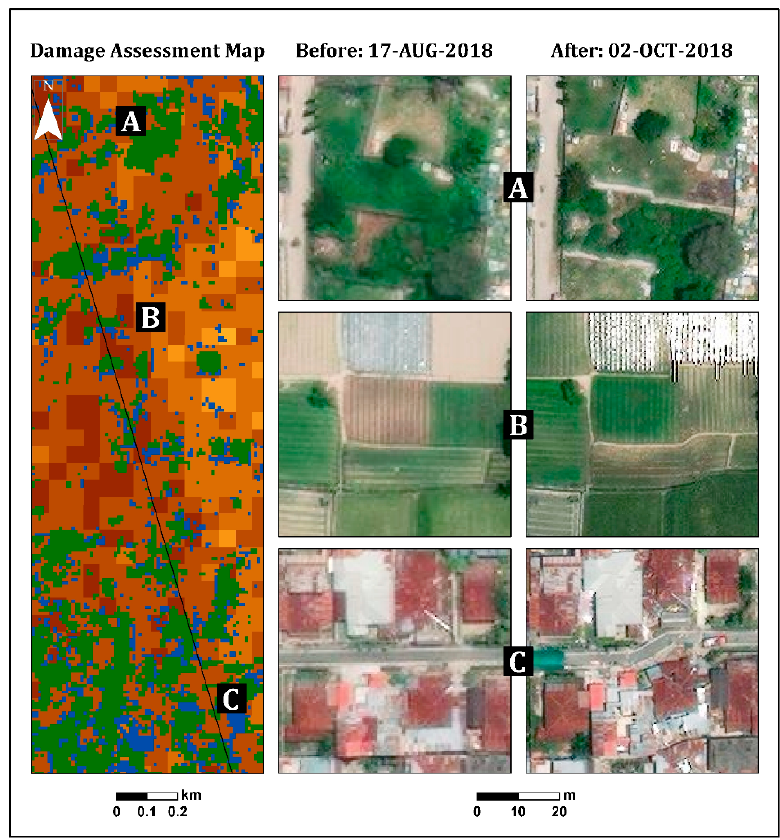
Figure 6. Illustration of the surface rupture caused by the 2018 Sulawesi Indonesia earthquake in ( A ) natural vegetation, ( B ) agricultural fields, and ( C ) a built-up area. In the urban area, the damage assessment map displayed less damage (light colors) in the inland region than in the coastal region, as expected (Figure 7). Refs. [38,39,42,43] displayed similar results, showing that most of the damage occurred along the Palu city coastline, where most of the buildings were washed away by the tsunami, and buildings inland were affected by the earthquake but not completely destroyed. Moreover, this map displayed the differences between the damage levels of the urban areas (coastline and inland regions) and the rural areas. As can be seen in Figure 7, the rural area displayed higher levels of damage (mostly darker shades) than the urban area, which displayed a variety of damage levels. These findings were further validated by high-resolution (50-cm spatial resolution) optical images recorded on 17 August (pre-event) and 2 October (post- event) 2018, using DigitalGlobe (https://www.digitalglobe.com/ecosystem/open-data/indonesia-earthquake-tsunami, accessed on 1 January 2022) (Figure 7).